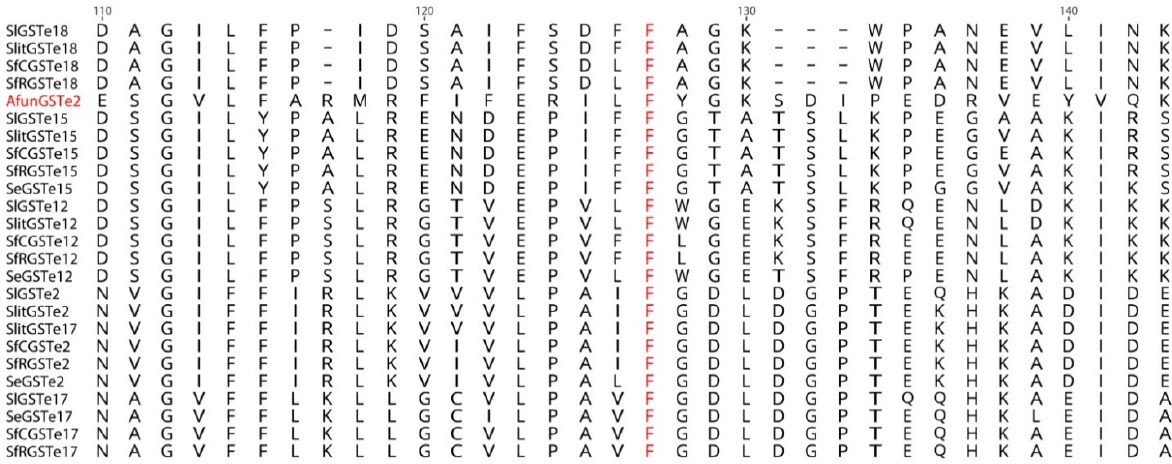
Figure 8. Alignment of a subset of GSTes from S. litura (Sl) S. frugiperda corn and rice strains (SfC and SfR), S. exigua (Se), S. littoralis (Slit) and AfunGSTe2 from Anopheles funestus (Afun, genbank accession number KC800363.1) harboring a L119F substitution. The L119F mutation (in red) is associated with DDT resistance in Anophelines [6].